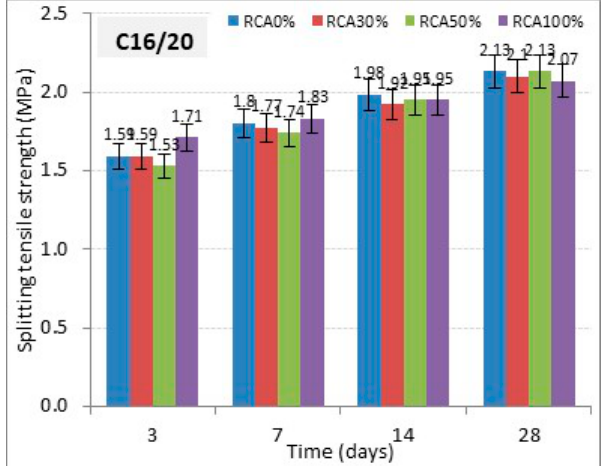
Figure 12. Effect of RCA content on the splitting tensile strength development for C16/20 concretes. Figure 12. E ff ect of RCA content on the splitting tensile strength development for C16 / 20